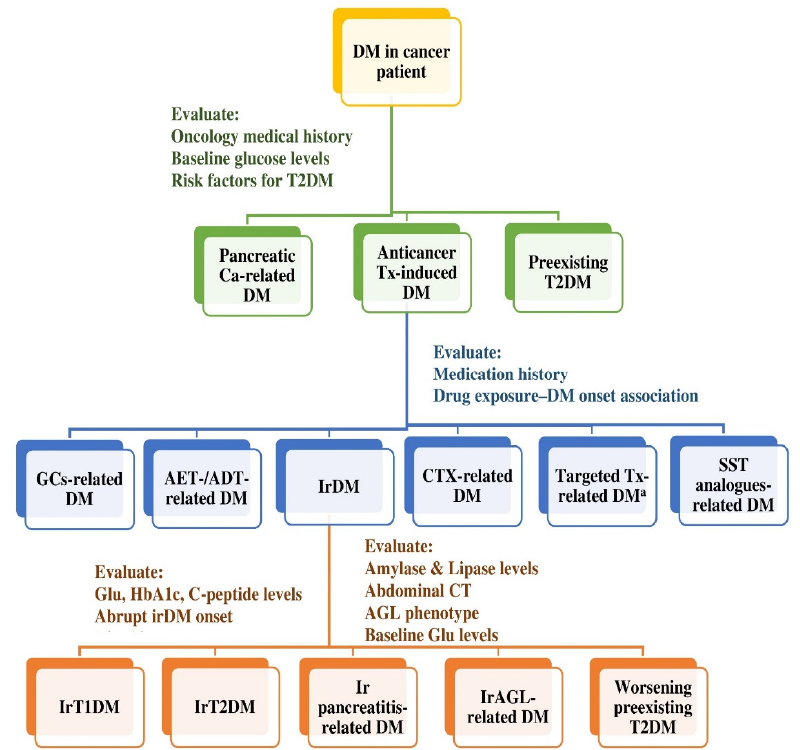
Figure 4. Differential diagnosis of DM and classification of irDM in cancer patients. a Targeted anti- cancer treatments known to cause DM include mammalian target of rapamycin (mTOR) inhibitors, phosphoinositide-3 kinase (PI3K) inhibitors, epidermal growth factor receptor (EGFR) inhibitors, multikinase inhibitors, tyrosine kinase inhibitors (TKIs), anaplastic lymphoma kinase (ALK) inhib- itors, and FMS-like tyrosine kinase-3 (FLT3) inhibitors.The first step in the differential diagnosis of DM in cancer patient involves pancreatic cancer-related DM, anticancer treatment-related DM, and pre-existing DM. This step is guided by evaluation of the patient’s oncology medical history, baseline glucose levels, and DM risk factors. Once the diagnosis of anticancer treatment-induced DM is set, the second step in the differential diagnosis of DM is to identify the explicit anticancer treatment that induced DM. This step is guided by evaluation of patient’s medication history and investigation of the association of the onset of DM with exposure to a drug known to cause DM, such as GCs, AET, ADT, ICPi, CTX, targeted therapy, and SST analogues.The classification of irDM into irT1DM or irT2DM can be facilitated by an evaluation of HbA1c levels and C-peptide levels, as well as by the abrupt onset of irT1DM. The classification of irDM into ir pancreatitis-related DM, irAGL-related DM, or ICPi-induced worsening of pre-existing T2DM can be facilitated by evaluation of amylase and lipase levels, abdominal CT, presence of any AGL phenotype in the patient after ICPi initiation, and baseline glucose levels. Abbreviations: ADT, androgen deprivation therapy; AET, anti-estrogen therapy; AGL, acquired generalized lipodystrophy; Ca, cancer; CT, computed tomography; CTX, chemotherapy; DM, diabetes mellitus; GCs, glucocorticoids; Glu, glucose; ICPi, immune checkpoint inhibitors; Ir, immune related; IrDM, immune-related diabetes mellitus; IrT1DM, immune-related type 1 diabetes mellitus; IrT2DM, immune-related type 2 diabetes mellitus; SST, somatostatin; Tx,